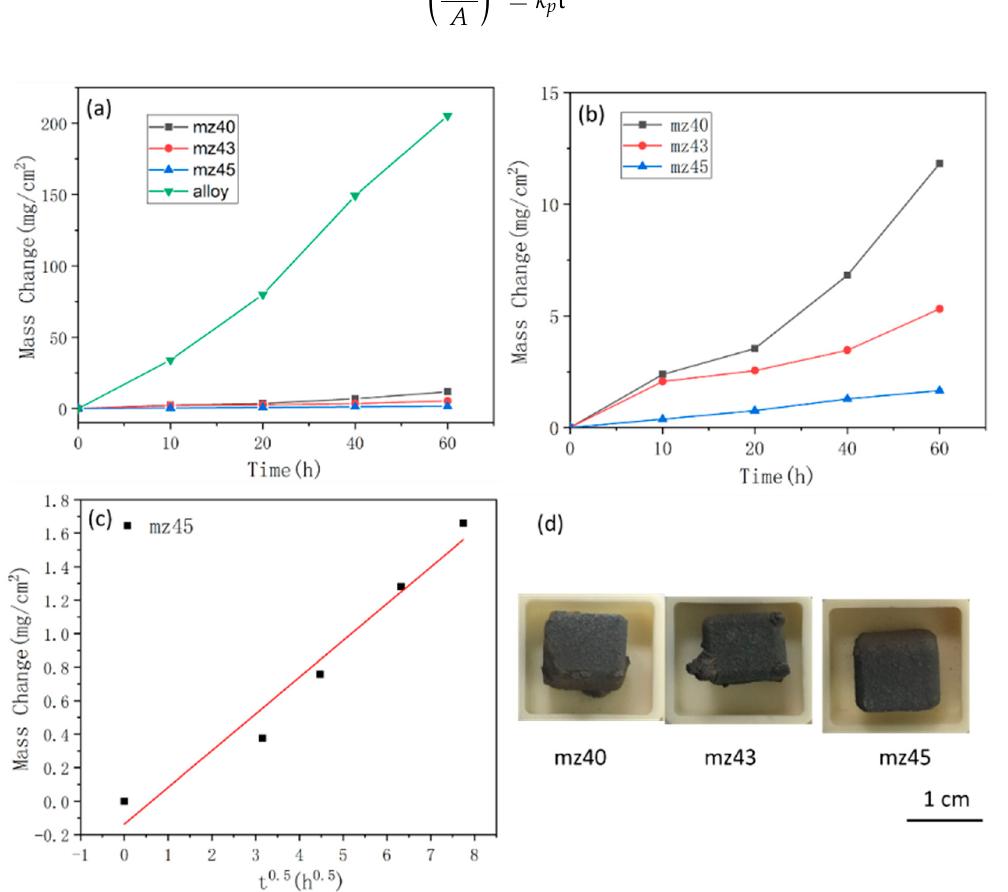
Figure 5. ( a ) Oxidation weight gain curve of Nb-Si based alloy and coatings, ( b ) oxidation weight gain curve of coatings, ( c ) representation of the weight gain versus the square root of time for mz45 oxidized in air, and ( d ) the photograph of oxidized samples.